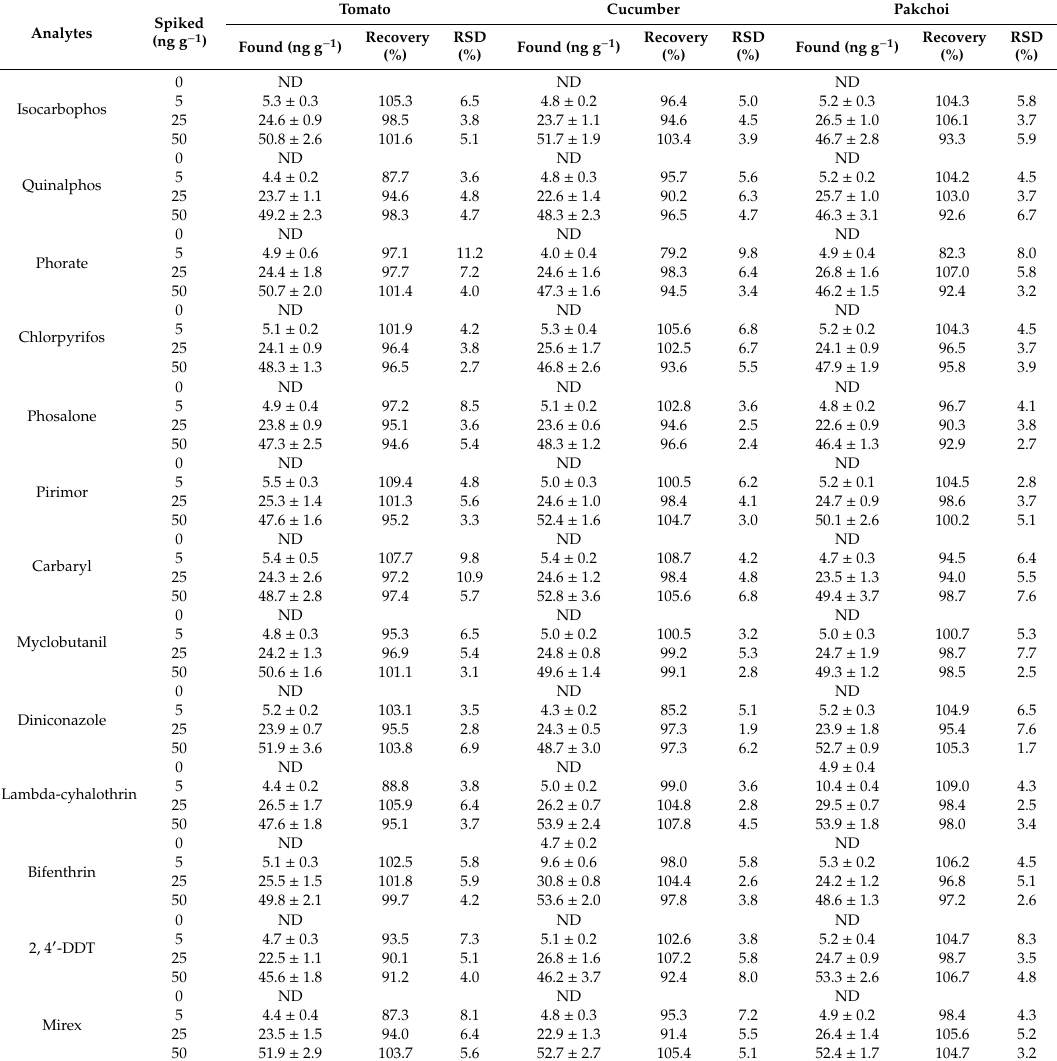
Table 2. Determinations of the insecticides and recovery in tomato, cucumber, and pakchoi samples. Analytes